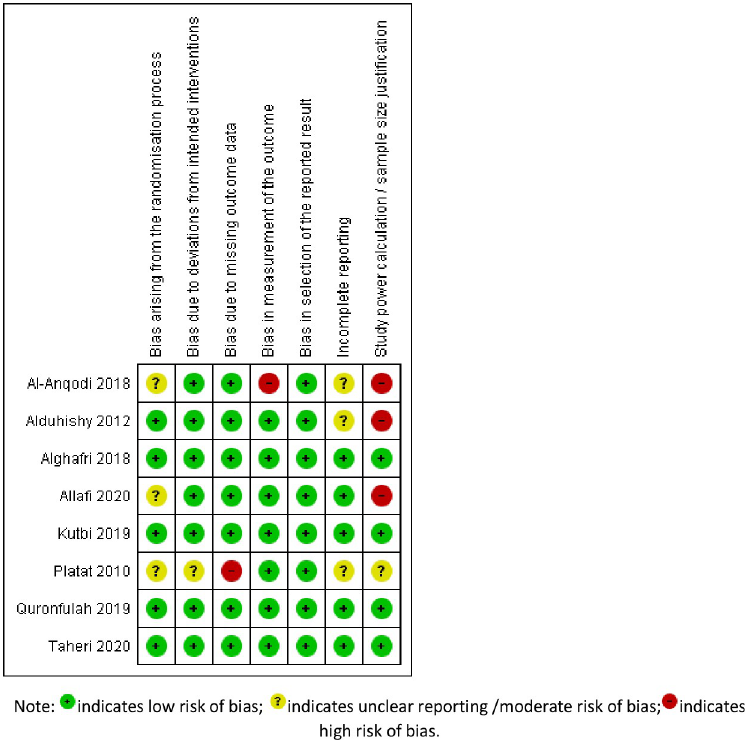
Fig 2. Risk of bias summary of included randomized control